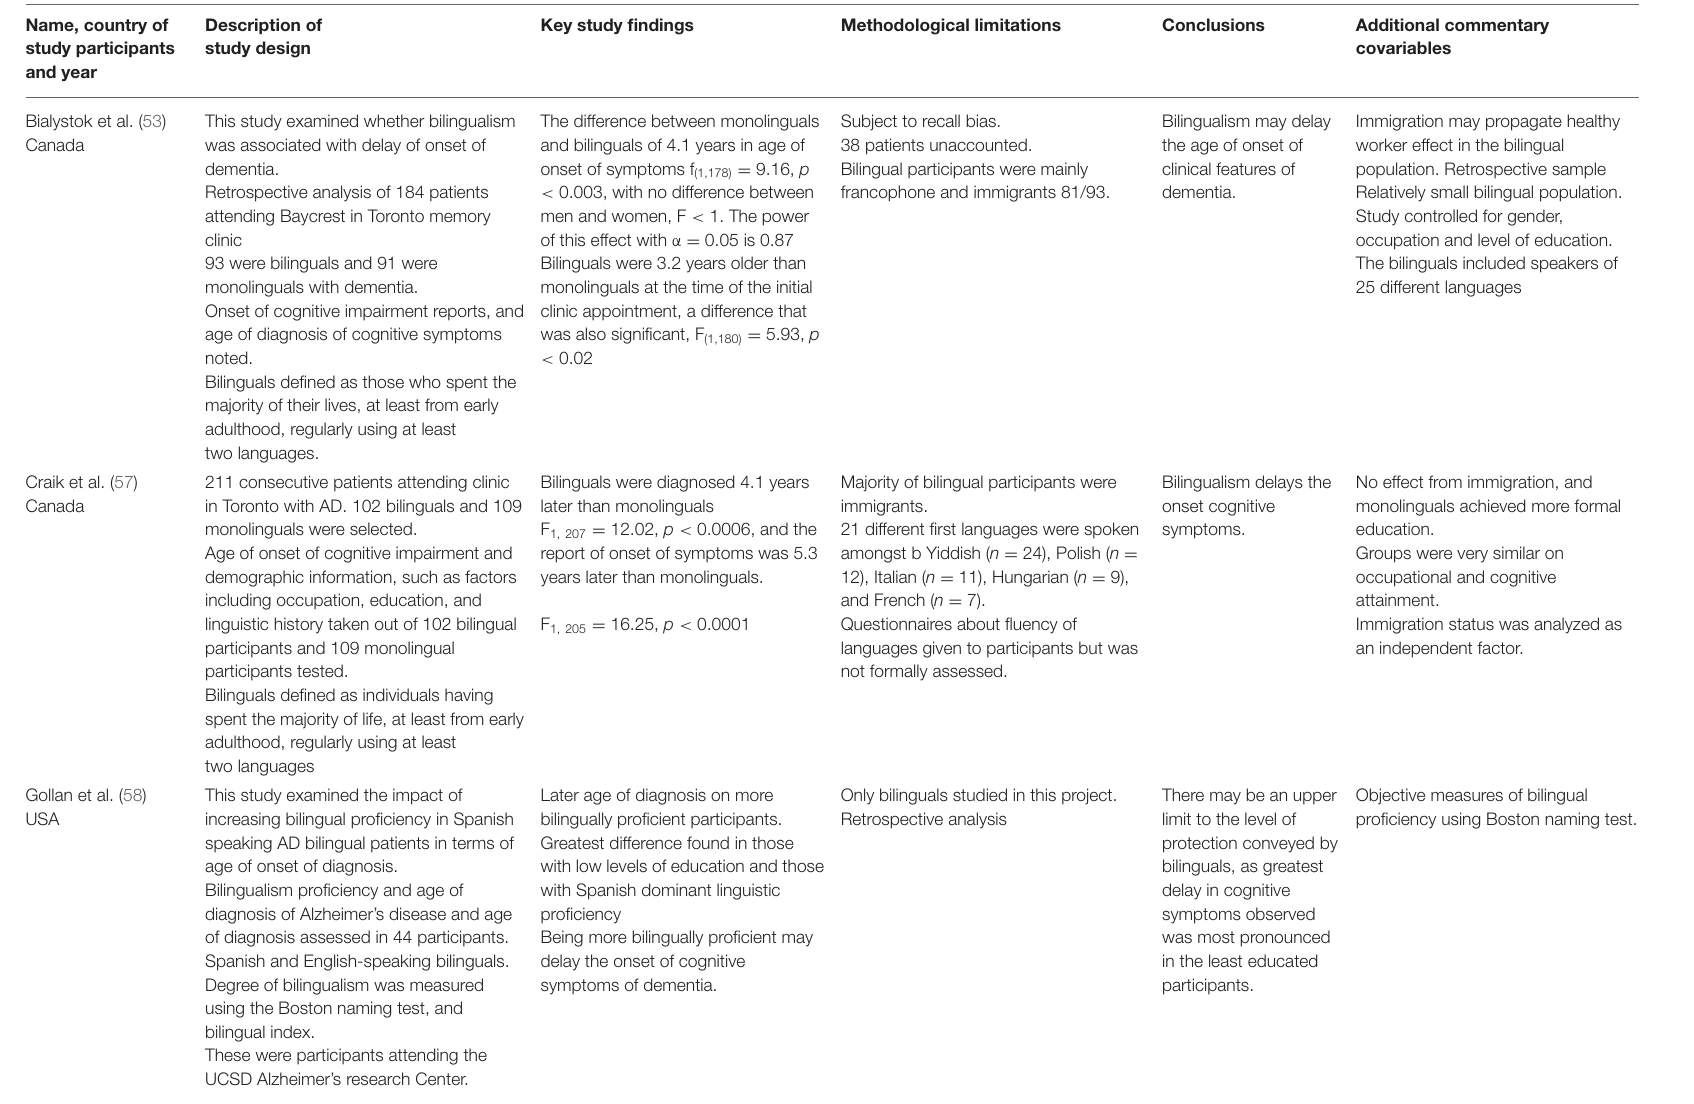
TABLE 1 | Studies of bilingualism and age of onset of dementia in